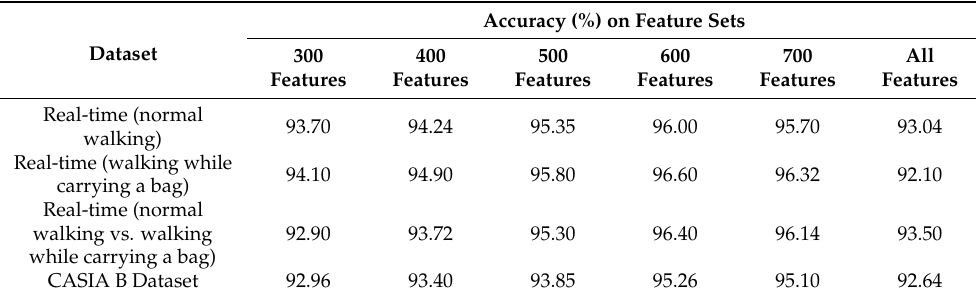
Table 6. Analysis of proposed feature-selection framework on numerous feature sets. *The OvA-SVM is employed as a classifier for this table.